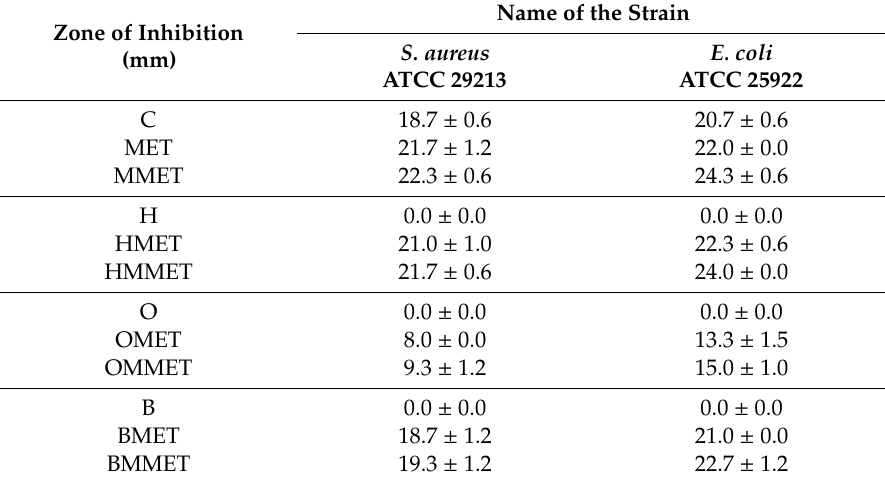
Table 6. Antibacterial activity of prepared hydrogels, oleogels, bigels containing MET (HMET, OMET, BMET), MMET (HMMET, OMMET, BMMET) and pure MET, MMET, commercially available product (C) as